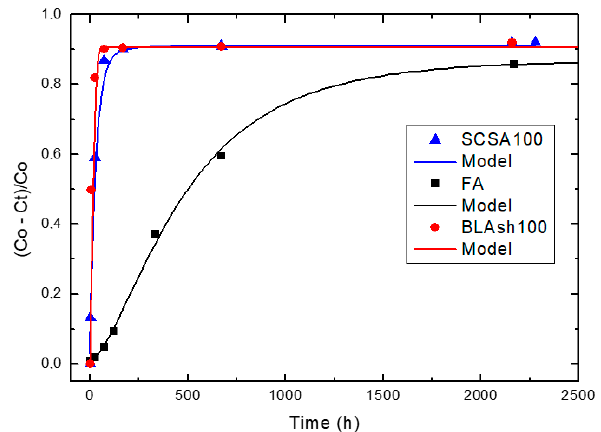
Figure 6. Relative loss of lime concentration versus reaction times for PSLSFA, PSISFA and LS ( Note: Black circle (experimental), solid line (model)).